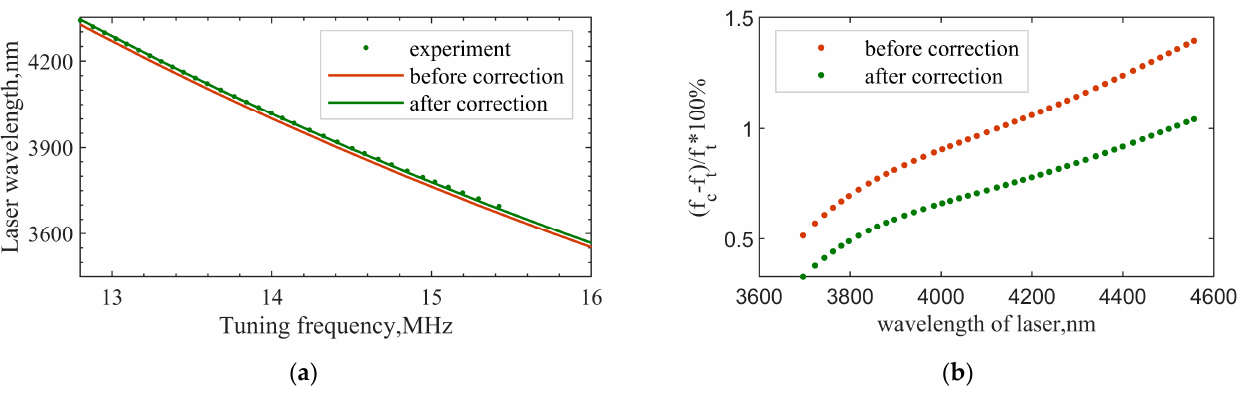
Figure 9. Correction result of the tuning curve. ( a ) Correction of tuning curve; ( b ) relative difference in central frequency.